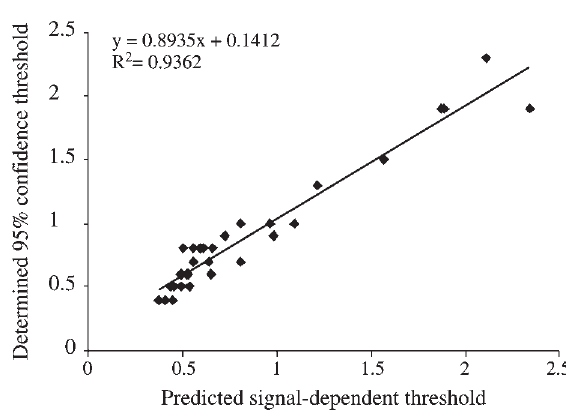
Figure 5 - Scatter plot of experimentally determined 95% confidence thresholds with predicted signal-dependent thresholds using the formulae: δ = 6.6157* β – 0.4325 and (1.72* δ /0.78, 0.89* δ /0.78, 0.59* δ /0.78, 0.48* δ /0.78, 0.45* δ /0.78, 0.41* δ /0.78). Five new replicate comparisons (notusedforestablishingthesignal-dependentthresholdsdescribedinthis paper) are included in this plot. There are 30 data points because each comparison has six thresholds.